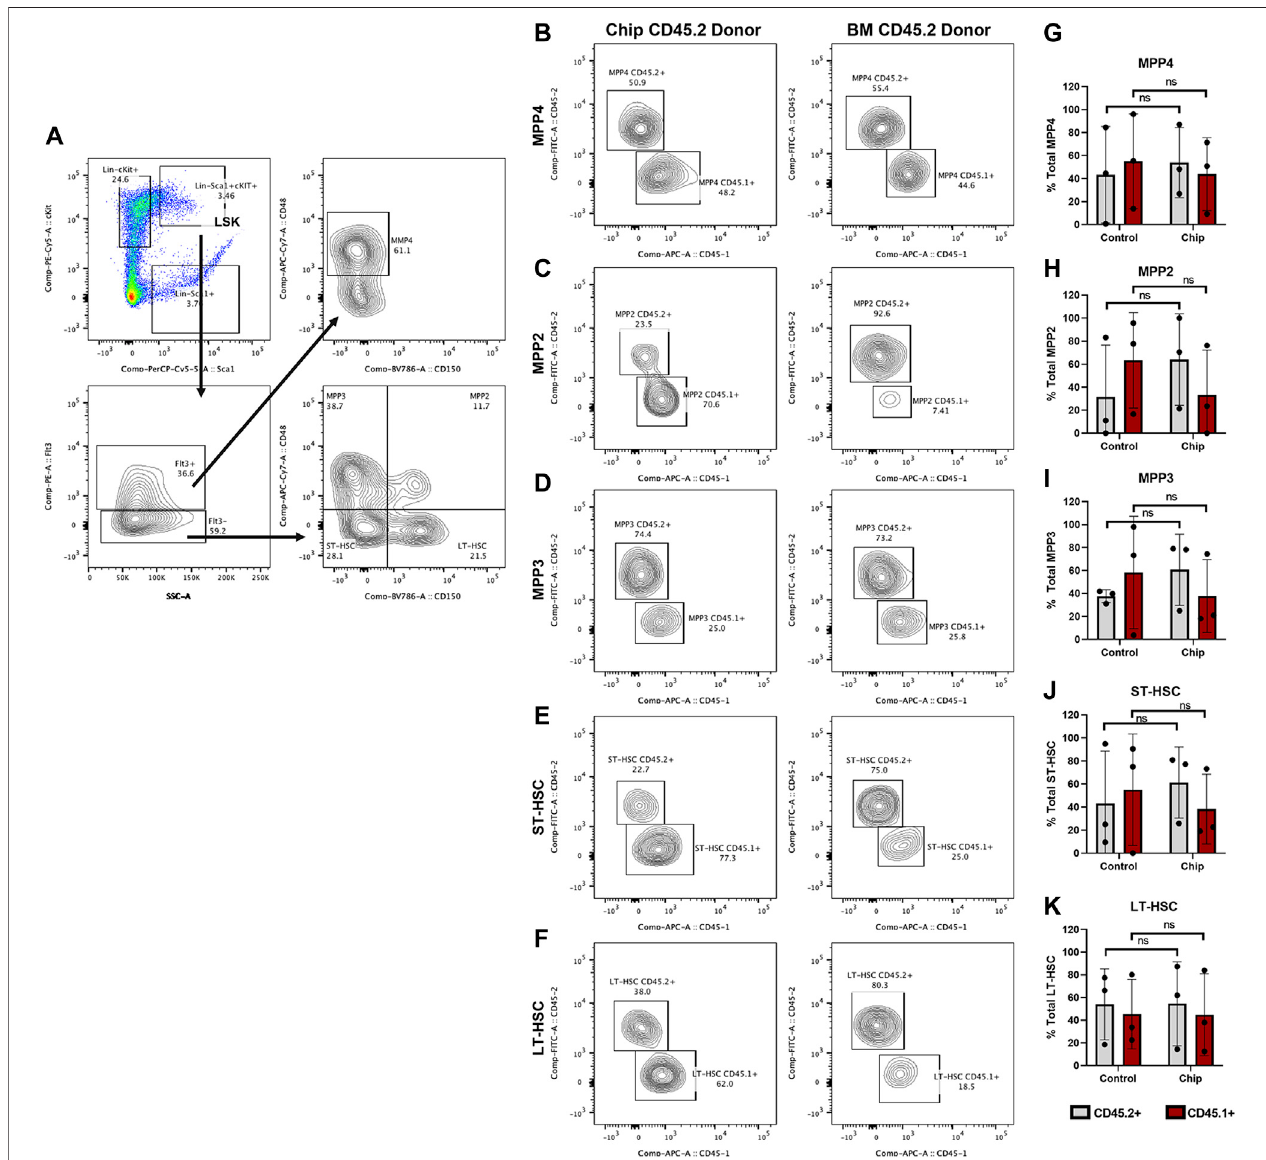
FIGURE7| Repopulationofmyeloid-biasedMPP2+andMPP3+,lymphoid-biasedMPP4+multipotentprogenitor andHSCpopulationsbyBMME-on-chipdonor cells. Subpopulations of speci fi c progenitor cells and short-term and long-term repopulating HSC (ST-HSC and LT-HSC) within the LSK populations were analyzed for micerecipients withCD45.2+and CD45.1+ chimerism (M1,M4, M5, C1, C4, and C5). (A) Flow cytometry gating ofLSKsubpopulations. (B – K) Representative contour plots and quanti fi cation of donor and competitor cells in LSK subpopulations. Statistical analysis was performed using multiple Whitney – Mann tests. N = 3 per group. Error bars = standard deviation, ns = non-signi fi